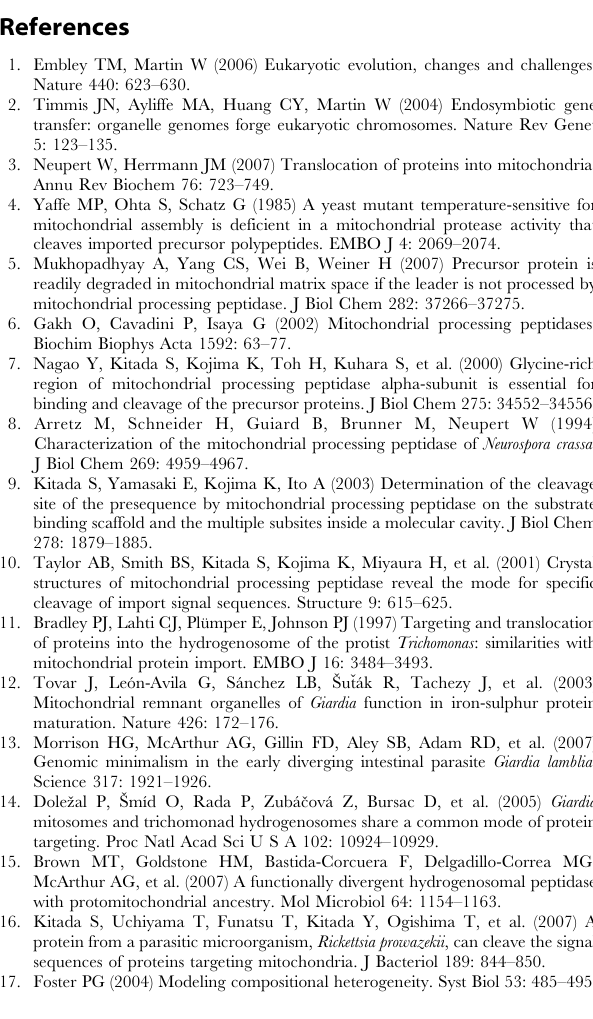
Table S1 N-terminal presequences of hydrogenosomal proteins predicted in the T. vaginalis proteome. Table S2 N-terminal presequences of mitosomal proteins found in G. intestinalis